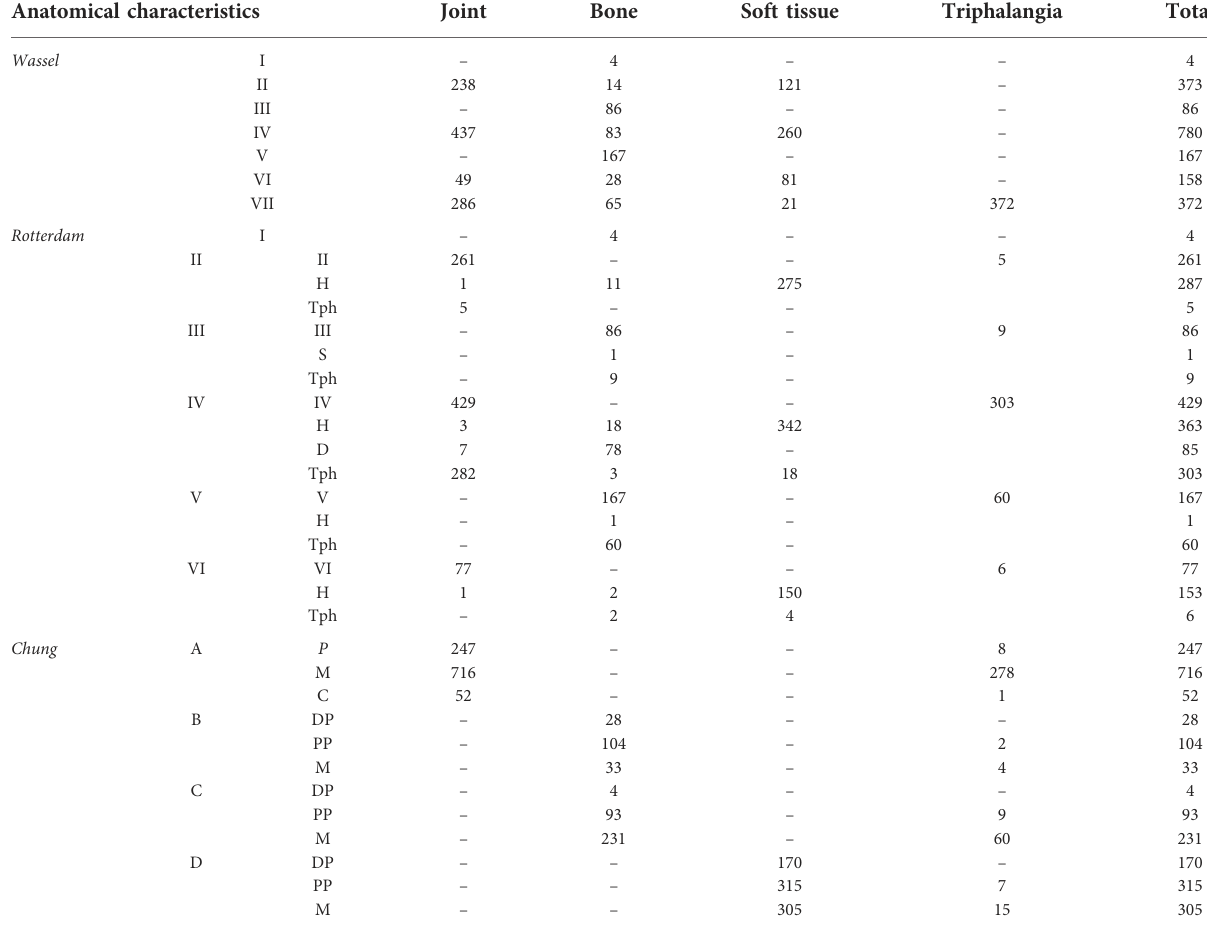
TABLE 2 Comparison of the proportion of the anatomical characteristics of the extra thumb connected to the main thumb in patients with CTD. Anatomical